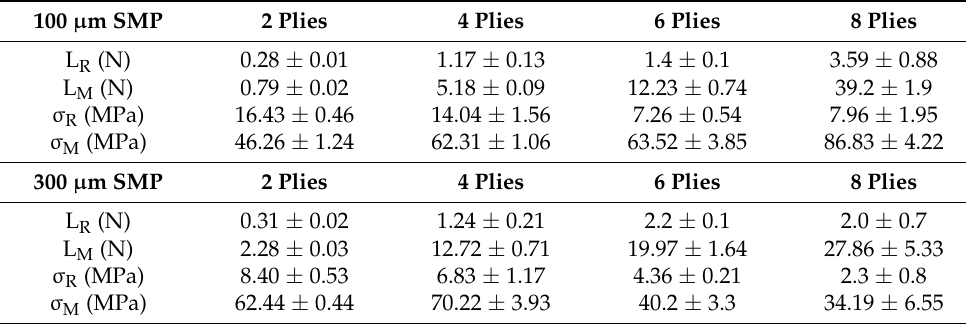
Table 4. SM data from multiple